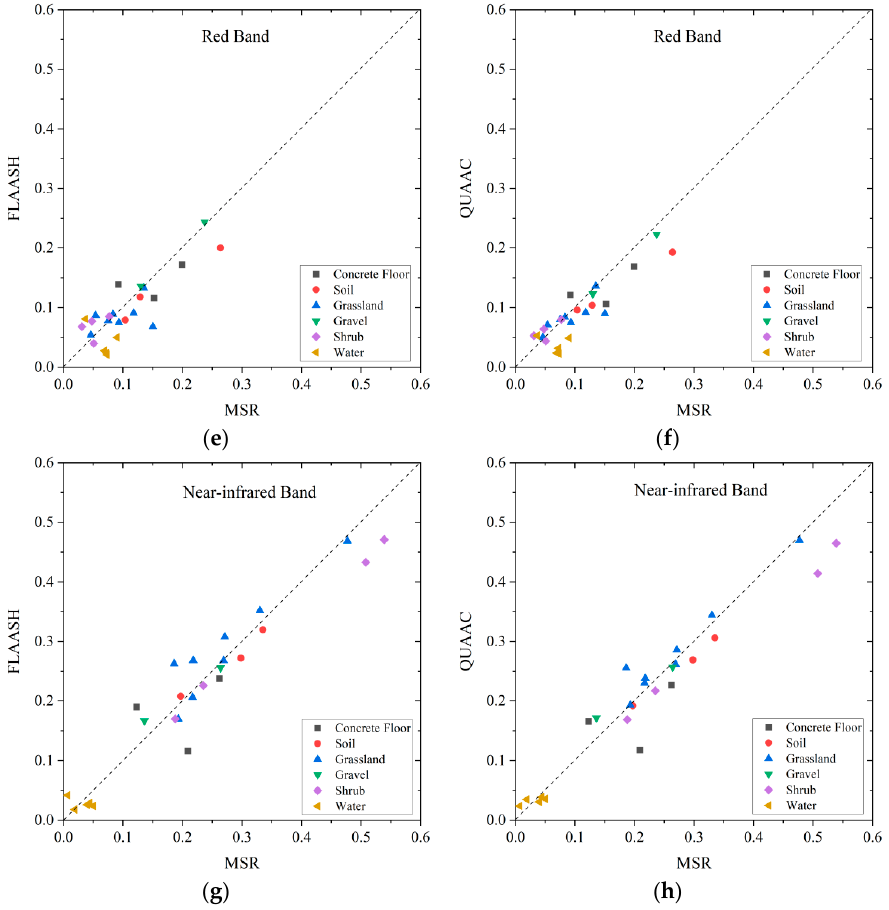
Figure 6. Scatter plots of QUAAC (right column) and FLAASH (left column) corrected SR versus MSR in each band. From top to bottom, the four bands are blue ( a , b ), green ( c , d ), red ( e , f ), and near-infrared ( g , h ). Different shapes and colors in the figure represent different surface types.